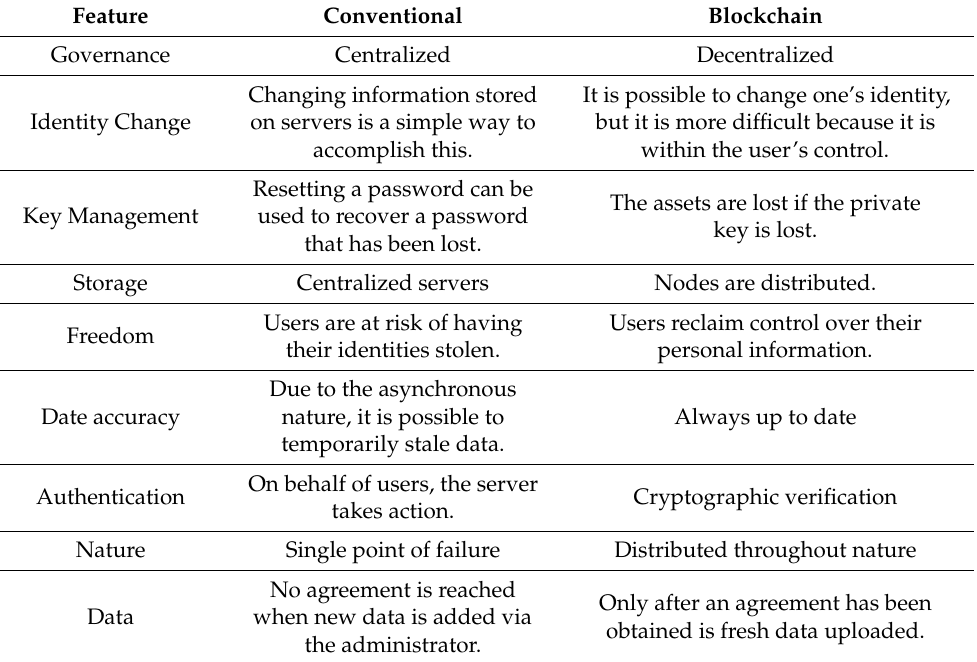
Table 1. Identity management systems that are centralized and decentralized are